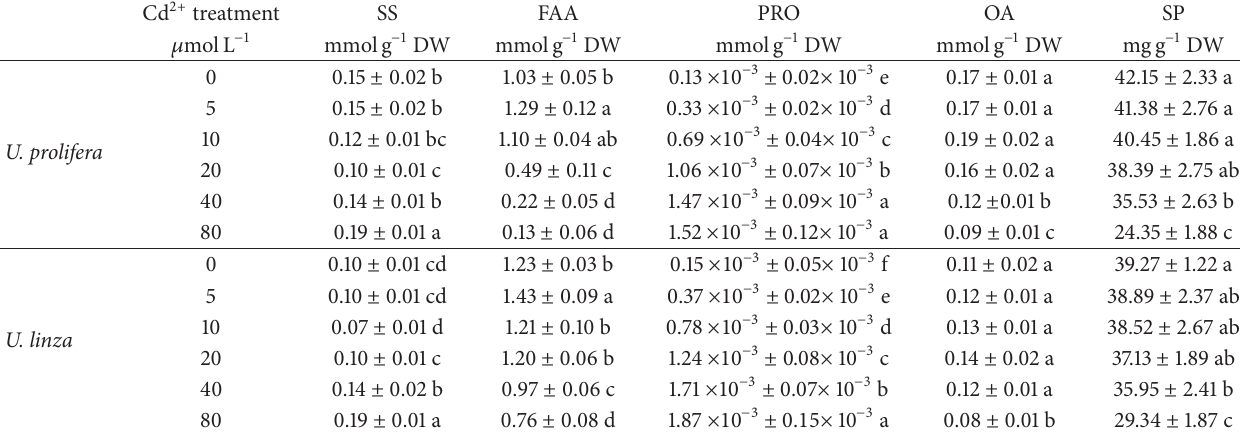
Table 2: Effects of different concentration of Cd 2+ (0, 5, 10, 30, 40, and 80 𝜇 molL − 1 ) on organic solute content of U. prolifera and U. linza .